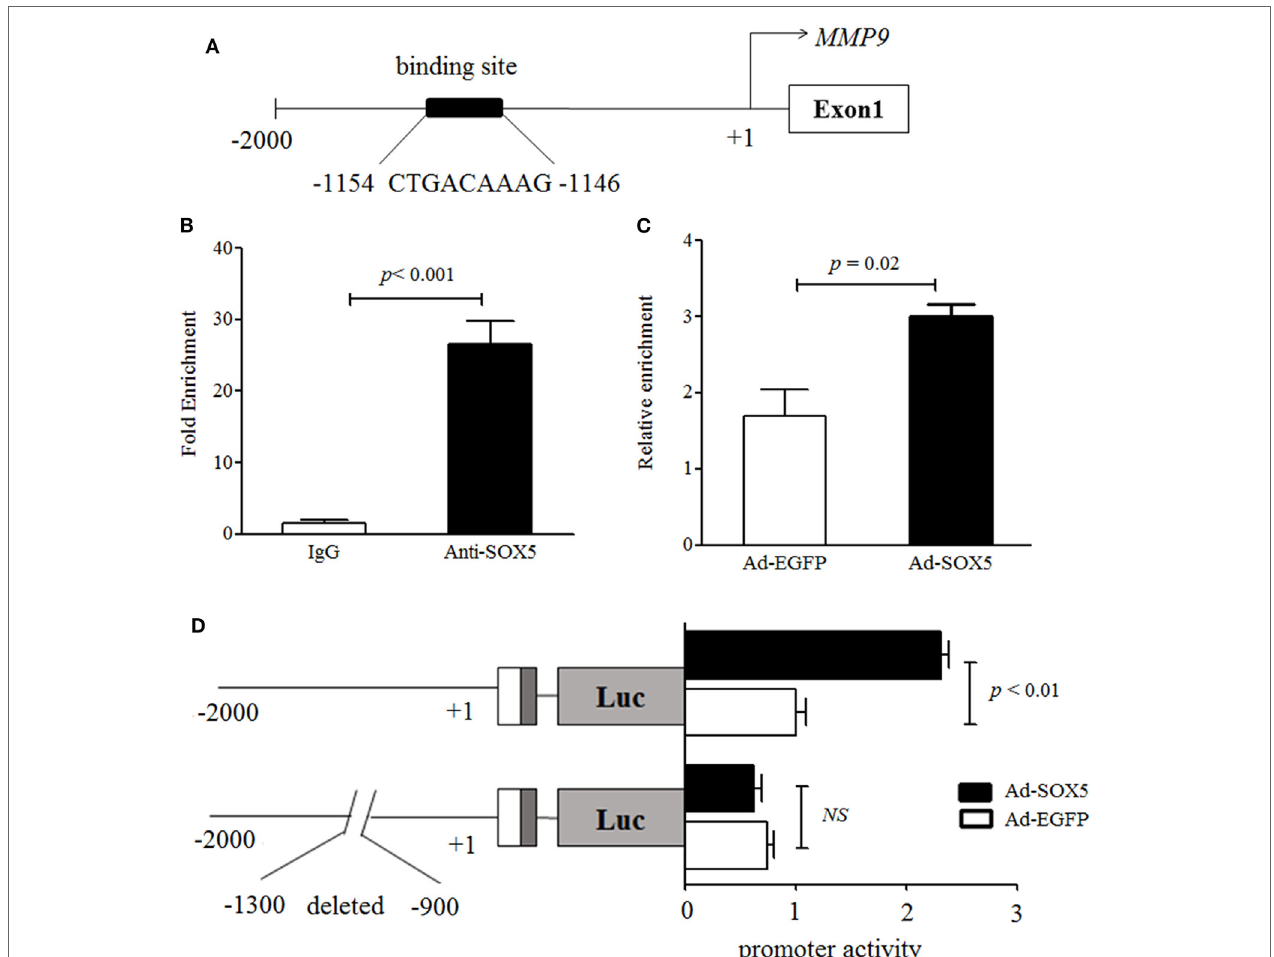
FigUre 4 | SOX5 promotes matrix metalloproteinase (MMP)-9 transcription via binding to the promoter region. (a) Schematic diagram of one putative SOX5- binding sites ( − 1,154~ − 1,146) in MMP-9 promoter region. (B) MH7A cell lysates were immunoprecipitated by Anti-SOX5 antibody or rabbit IgG as control. qPCR analyses the enrichment of MMP-9-specific DNA in MH7A cells. (c) MH7A cells were transfected with Ad-SOX5 or Ad-EGFP for 72 h, and then harvested for chromatin immunoprecipitation assay. The cell lysates were immunoprecipitated by SOX5 antibody. qPCR analyses the enrichment of MMP-9-specific DNA in MH7A cells. (D) Truncation analysis of the MMP-9 reporters. Two kinds of reporters, including the full 2-kb MMP-9 promoter and deletion putative SOX5-binding site from − 1,300 to − 900 in promoter, were analyzed for their activity. MH7A cells were transfected with Ad-SOX5 or Ad-EGFP for 48 h, then transfected with these two kinds of reporters for 24 h, respectively. Data are each representative of three independent